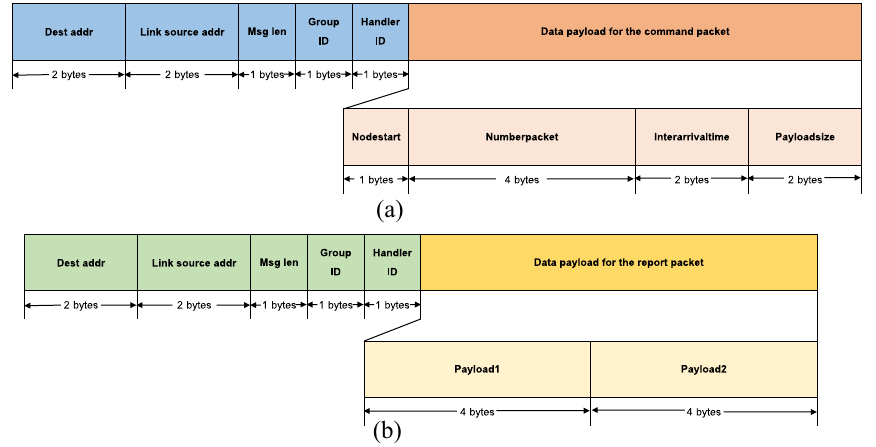
Fig. 2 The packet format for the proposed